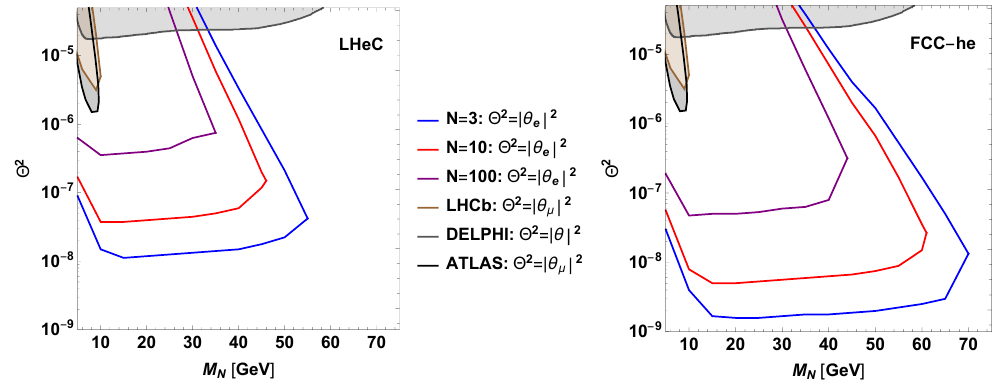
Figure 6 . Parameter space giving rise to N = 3 ; ; 10 ; 100 heavy neutrino decays with a displaced secondary vertex at the LHeC (left) and the FCC-he (right). The gray area denotes the best exclusion limits from the experiments from ATLAS [6], LHCb [36], LEP [2], and MEG [37]. In this (cid:12)gure, j (cid:18) (cid:11) j = 0 for (cid:11) 6 = e . Notice that each experiment is sensitive to a di(cid:11)erent set of active-sterile mixing parameters, as indicated in the legend.